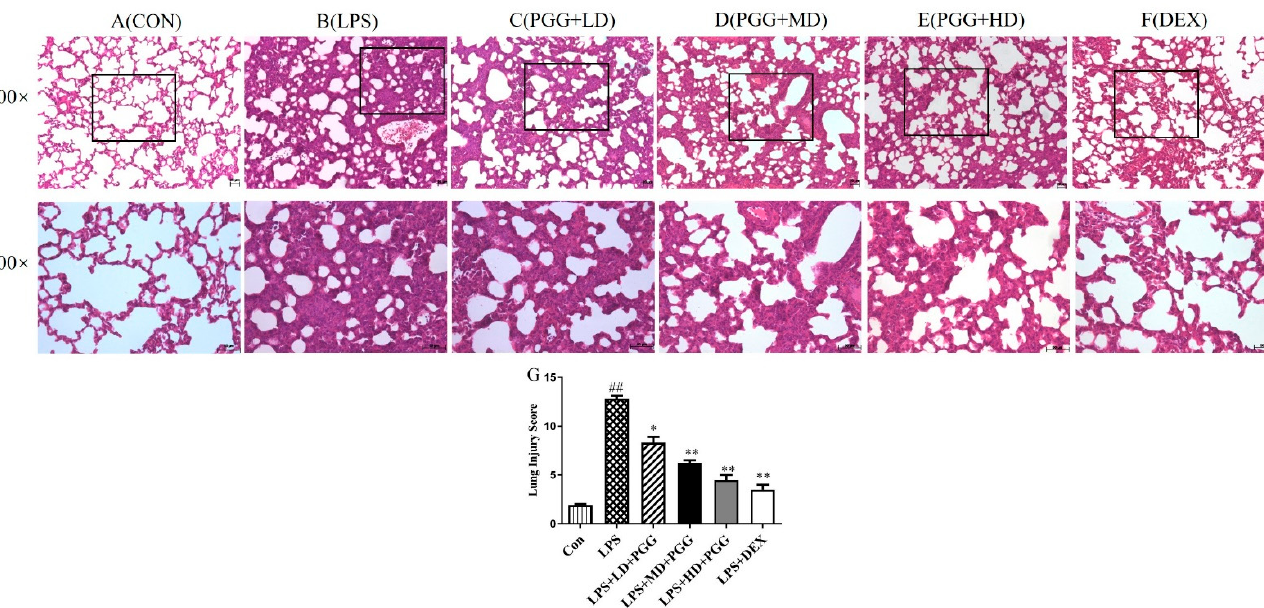
Figure 2. PGG alleviates LPS-induced pathological changes in lung tissue ( n = 5). Representative lung tissue by hematoxylin-eosin (H&E) staining in each group ( A – G ). Lung tissue sections were stained with H&E for histopathologic analysis (magnification 100×, 200×, n = 5). Scale bar, 50 μ m. ( A ) Control group, ( B ) LPS group, ( C ) PGG (LD) group, ( D ) PGGG (MD) group, ( E ) PGG (HD) group, ( F ) DEX group, ( G ) lung Injury Score. Values are expressed as the mean ± standard deviation (SD). ## p < 0.01 vs. Con group; * p < 0.05, ** p < 0.01 vs. LPS group. Con, control group; DEX, dexamethasone;